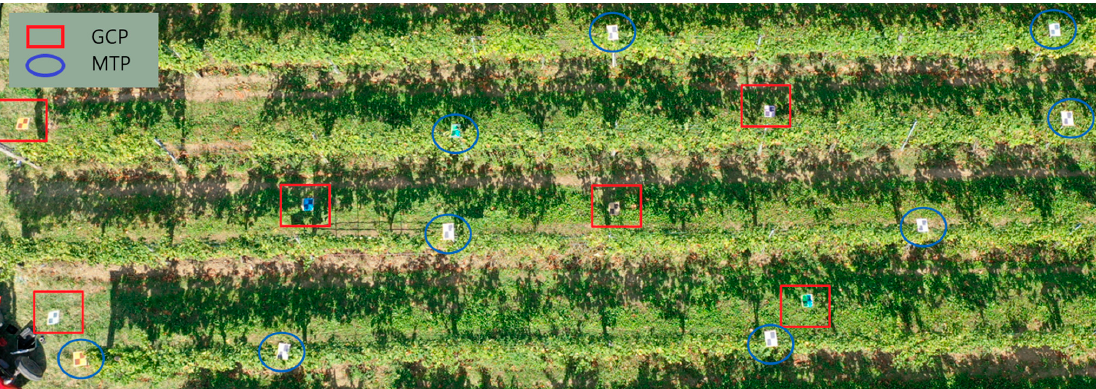
Figure 2. Lidar and UAS survey area 28 m × 7 m (4 vine rows) and the distribution of GCPs and MTPs. The GCPs were fixed on the ground between the vine rows and the MTPs were fixed at the top of the vine rows.